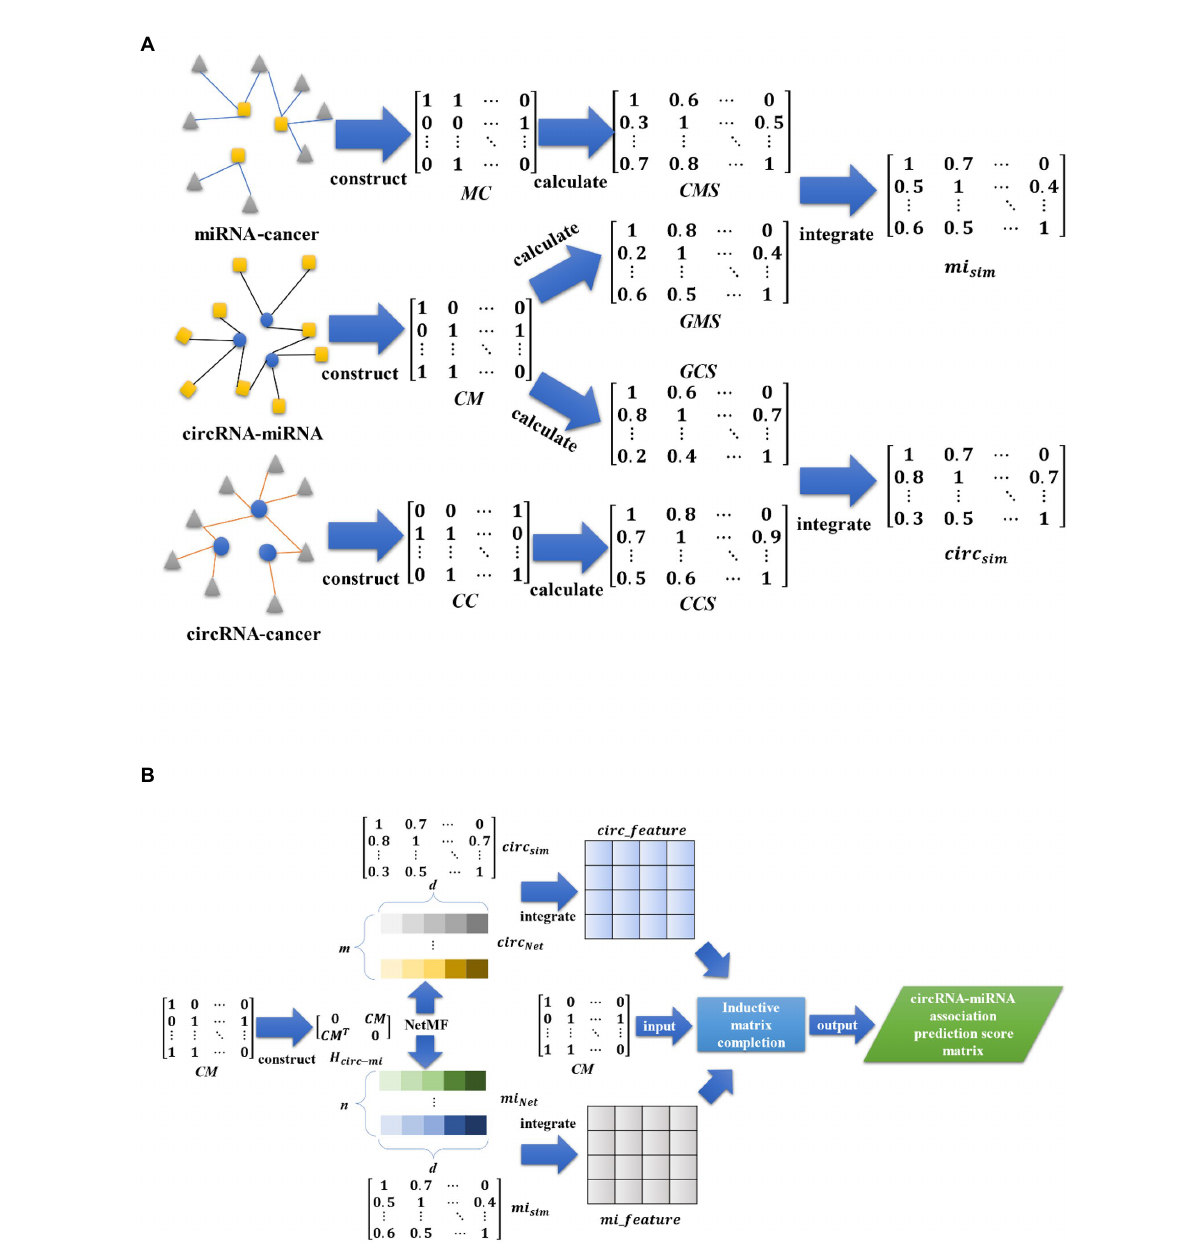
FIGURE 1 (A) Overview of interaction prediction model for circRNA and miRNA based on multi-biological interaction (1). (A) Mainly shows the construction of the incidence matrix, the calculation of similarity, and the fusion of similarity. (B) Overview of interaction prediction model for circRNA and miRNA based on multi-biological interaction (2). (B) Mainly shows the construction of heterogeneous networks, feature extraction based on NetMF algorithm, feature fusion, and calculation of interaction prediction